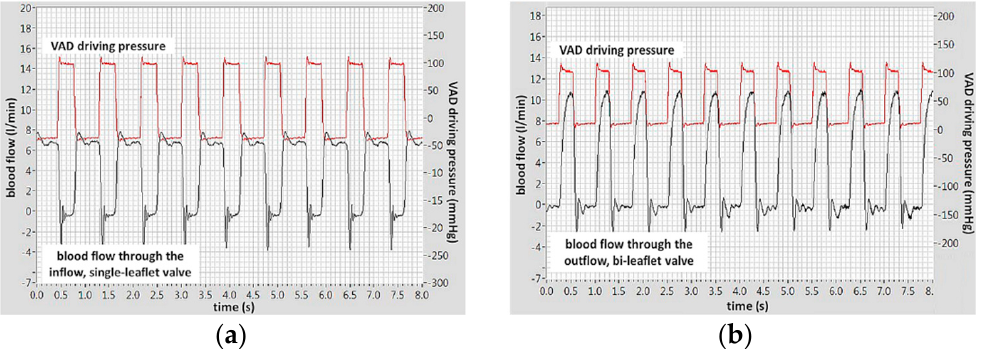
Figure 18. Blood flow and VAD driving pressures waveforms: ( a ) through the inflow valve, ( b ) through the outflow valve. Hemodynamic conditions: VAD afterload pressure = 100 mmHg and heart rate = 50 BPM.